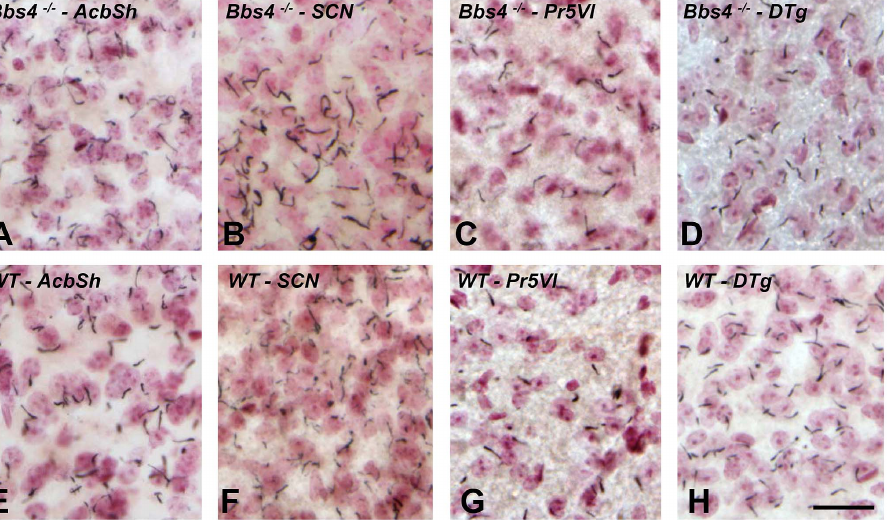
Figure 6. Similar distribution of ACIII immunopositive PNC in Bbs4 -/- (A–D) compared to WT (E–H) regions of the brain is illustrated. AcbSh – nucleus accumbence shell; SCN – suprachiasmatic nucleus; Pr5Vl - principal sensory trigeminal nucleus, ventrolateral subdivision; DTg - dorsal tegmental nucleus. The data was collected from three WT and five Bbs4 -/- mice. Scale bars= 25 m m for A -H.